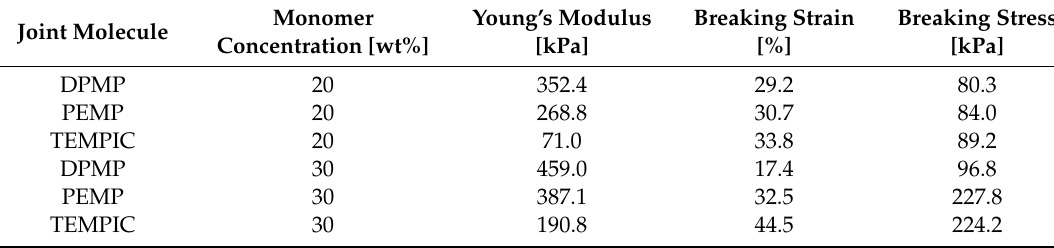
Figure 3. Stress–strain curves of ( a ) gels containing 20 wt % monomer, (i) DPMP- DAIM TFSI, (ii) PEMP-DAIM TFSI and (iii) TEMPIC- DAIM TFSI gels, and ( b ) gels containing 30 wt % monomer, (i) DPMP-DAIM TFSI, (ii) PEMP- DAIM TFSI and (iii) TEMPIC-DAIM TFSI gels; solvent: Li-TFSI/PC (1 M). Table 1. Mechanical properties of joint-linker type gels.